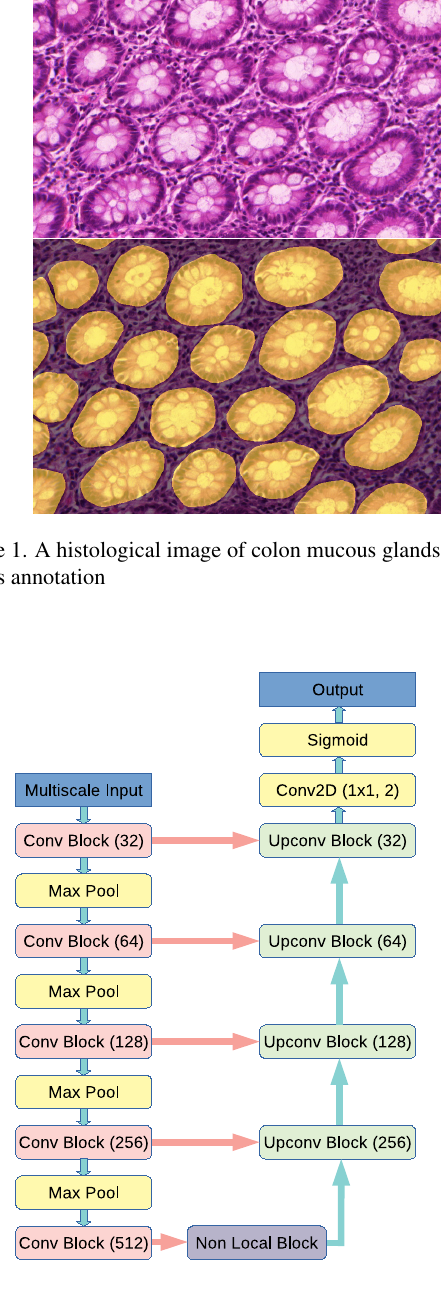
Figure 2. Proposed architecture for mucous glands segmentation